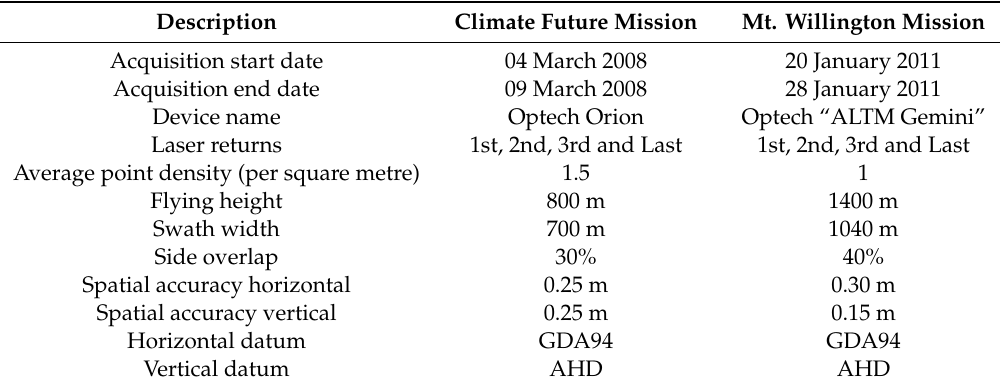
Table 2. LiDAR dataset specification (The LIST, 2019).